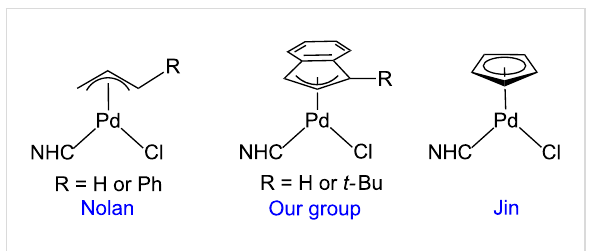
Figure 1: General depictions of allyl and related precatalysts that are highly active for the Suzuki–Miyaura reaction with NHC ligands.